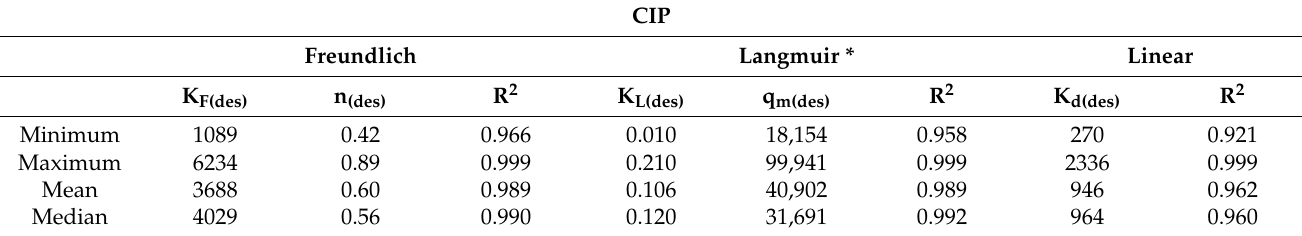
Table 5. Minimum, maximum, mean and median of the parameters resulting from the fits of the experimental desorption data to the Freundlich, Langmuir and linear models, for ciprofloxacin (CIP) and trimethoprim (TRI). K F(des) (L n µ mol 1 − n kg − 1 ) is the Freundlich affinity coefficient; n (des) (dimensionless) is the Freundlich linearity index; K L(des) (L µ mol − 1 ) is the Langmuir constant related to adsorption energy; q m(des) ( µ mol kg − 1 ) is the maximum soil adsorption capacity; K d(des) (L kg − 1 ) is the distribution constant in the linear model; R 2 : coefficient of